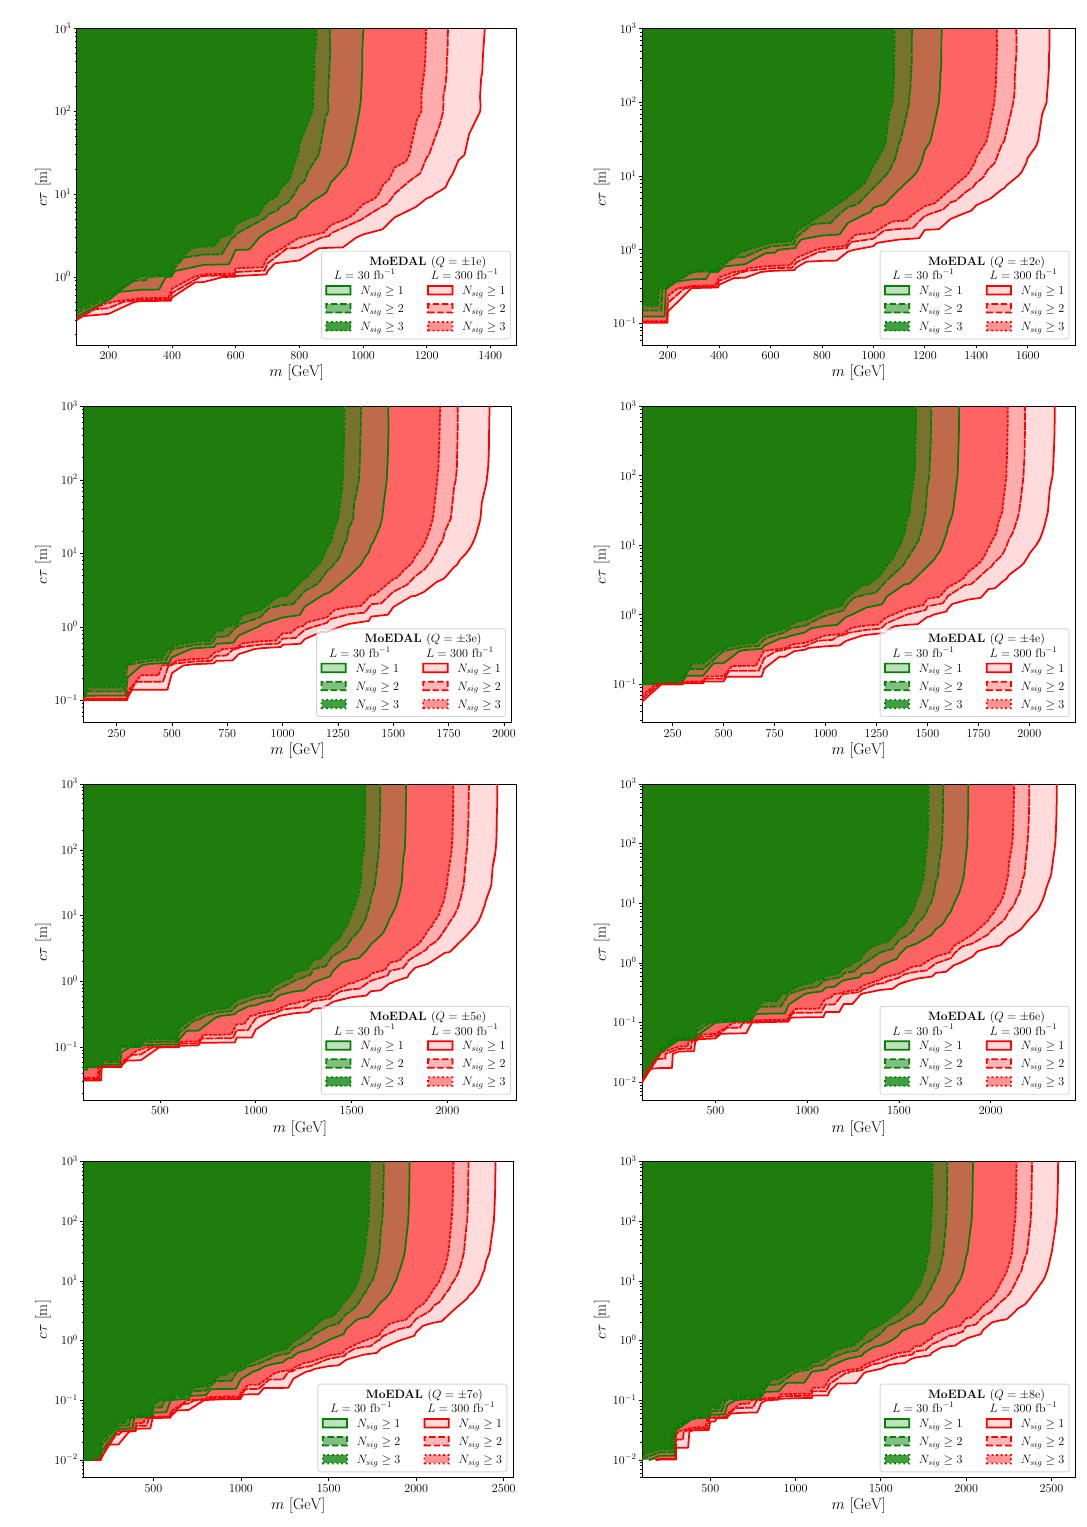
Fig. 17 Model-independent detection reach at MoEDAL in the ( m , c τ ) parameter plane for coloured scalars. The solid dashed and dotted contours correspondto N sig = 1,2and3,respectively.GreenandredcontourscorrespondtoRun-3 ( L = 30 fb − 1 ) andHL-LHC ( L = 300 fb − 1 ) luminosities